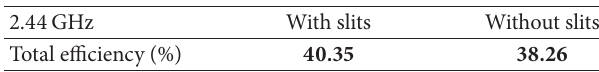
Table 1: Simulated total efficiency at 2.44 GHz.